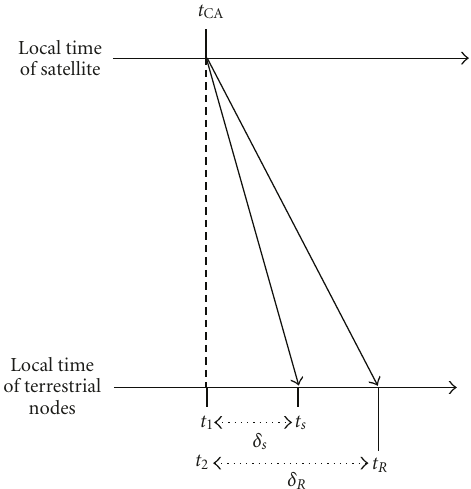
Figure 4: Time synchronization between the protocol participants in the extended TESLA certificate protocol.